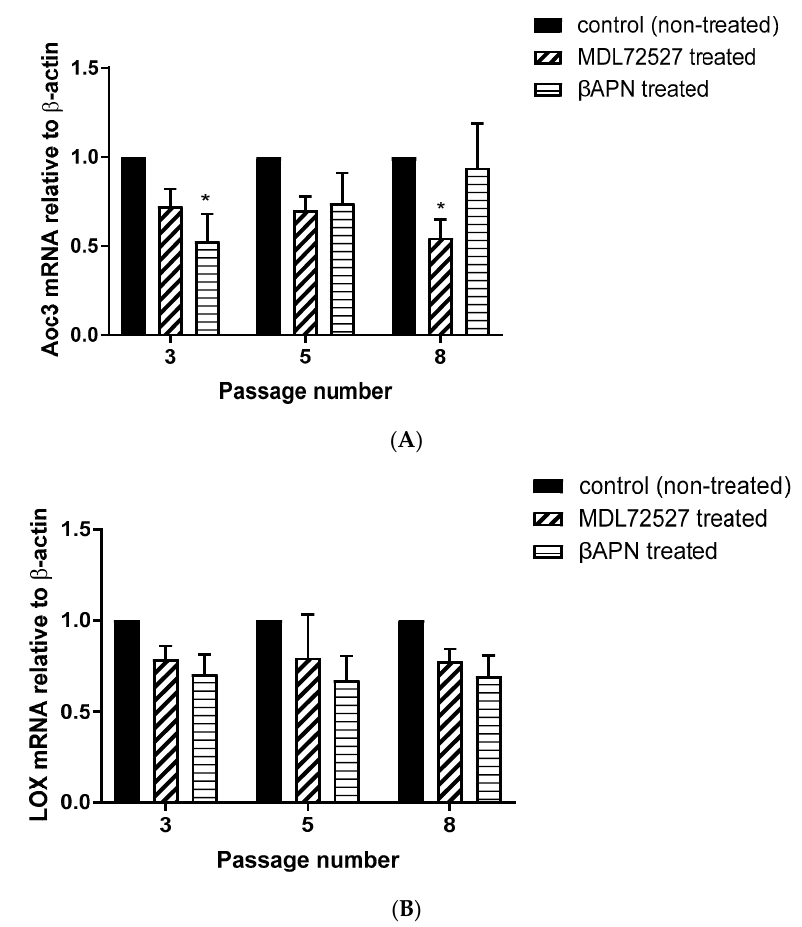
Figure 5 . Aoc3 mRNA expression (expressed as fold-change compared with control after normalization to the housekeeping gene β -actin) in non-treated (control: black bars), MDL72527 treated (hatched bars), and β APN treated (horizontal line bars) VSMCs from passages 3, 5, and 8 ( A ). At passage 3, (* p < 0.05 for β APN treated vs. non-treated cells), and passage 8, (* p < 0.05 for MDL72527 treated vs. non-treated cells). LOX mRNA expression (expressed as fold-change compared with control after normalization to the housekeeping gene β -actin) in non-treated (control: black bars), MDL72527 treated (hatched bars) and β APN treated (horizontal line bars) VSMCs from passages 3, 5, and 8 ( B ). No statistical difference ( p > 0.05) was detected after β APN and MDL72527 treatment. Values are mean ± S.E.M. (n =